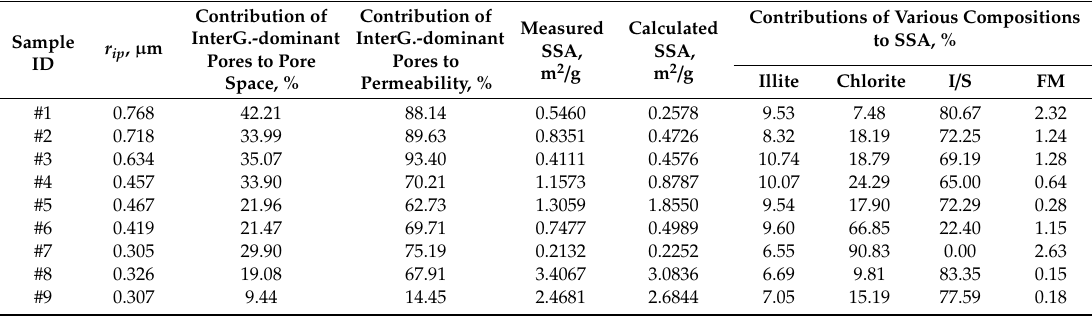
Table 3. Lists of the contributions of intergranular-dominant pore networks to total pore space and permeability and the contributions of various compositions to SSA calculated from Equation (8) for the studied nine tight rocks.